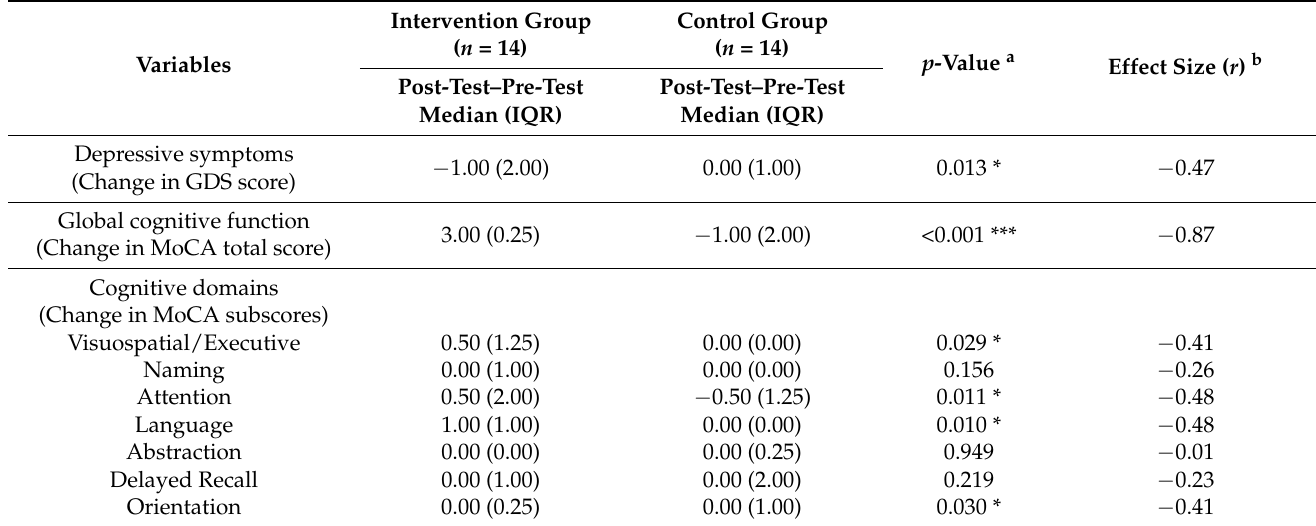
Table 3. Comparisons of change scores (post-test–pre-test) on depressive symptoms and cognitive performance between the intervention and control